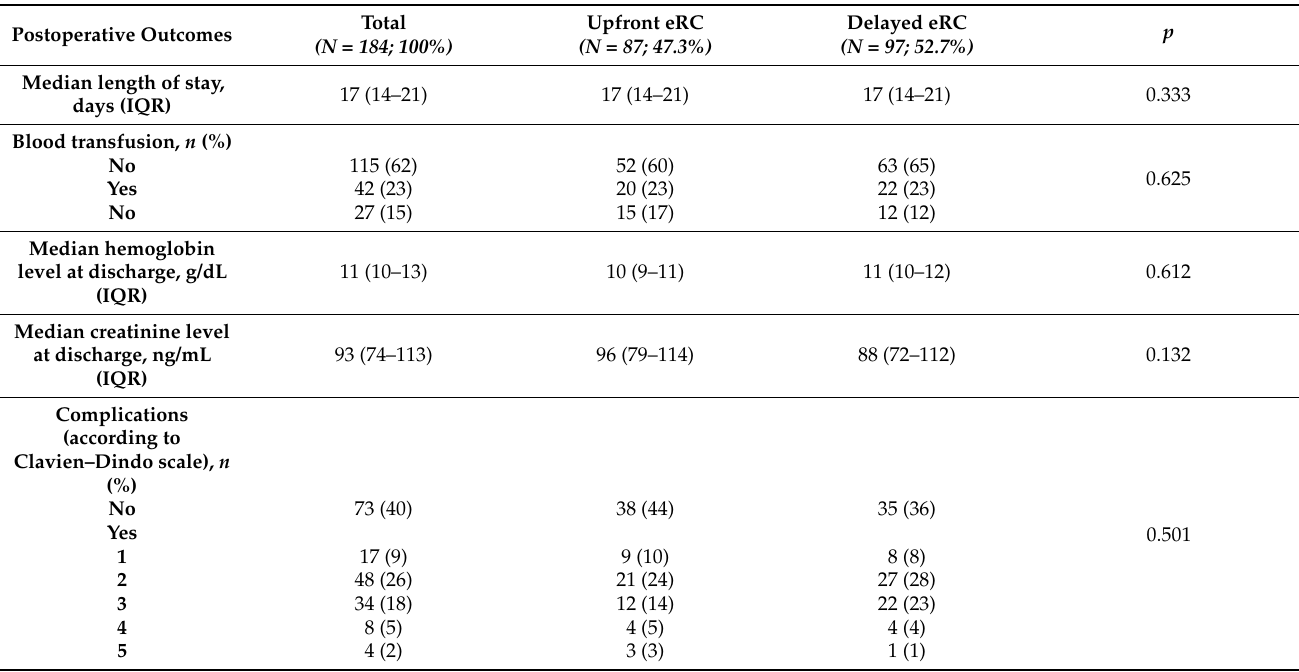
Table 3. Postoperative outcomes of included patients treated with upfront or delayed eRC for